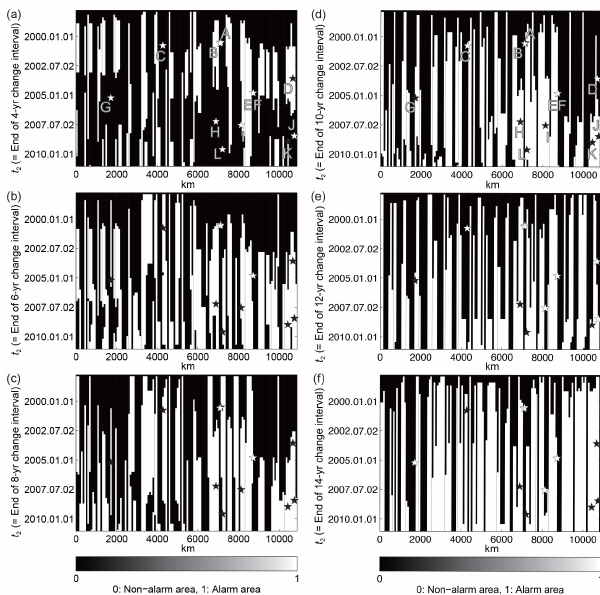
Fig. 8. As in Fig. 6, but for a cutoff magnitude of